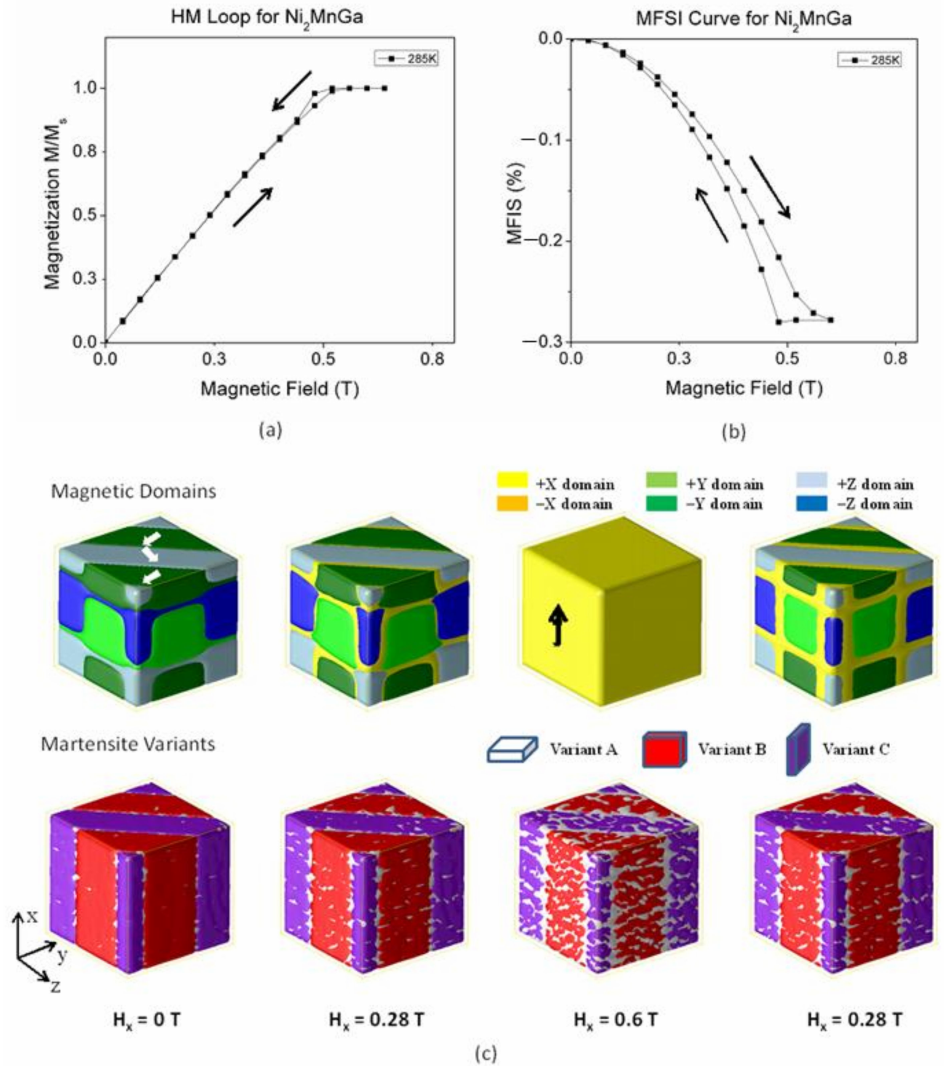
Figure 2. The field dependence of magnetization and magnetic field-induced strain (MFIS) for Ni-Mn- Ga alloy. ( a ) M/Ms vs. applied field curves; ( b ) MFIS vs. applied field curves; ( c ) the ferromagnetic domain structure and martensite variant evolution under applied field along the x -axis (without